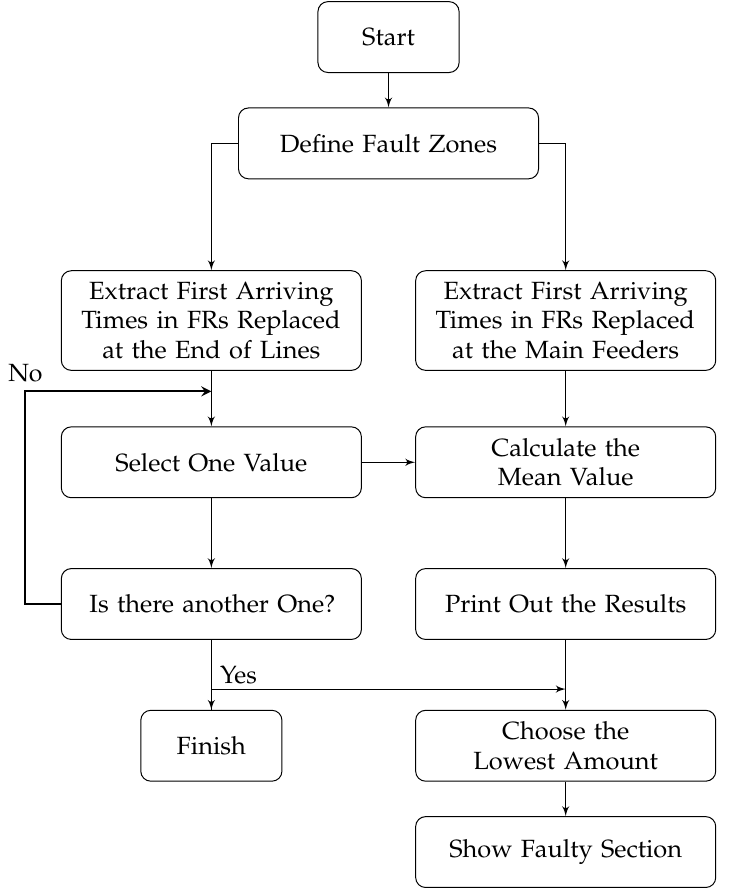
Figure 6. Section diagnosis algorithm. FR, fault